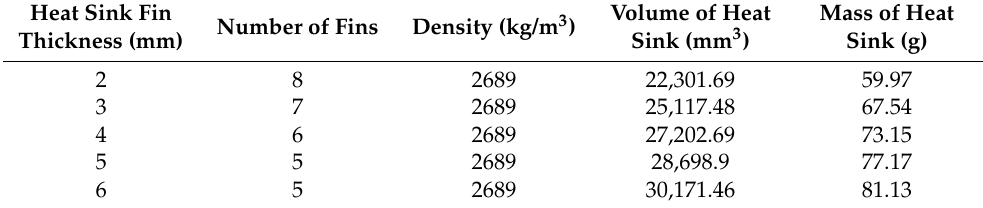
Table 2. Mass of different cylindrical heat